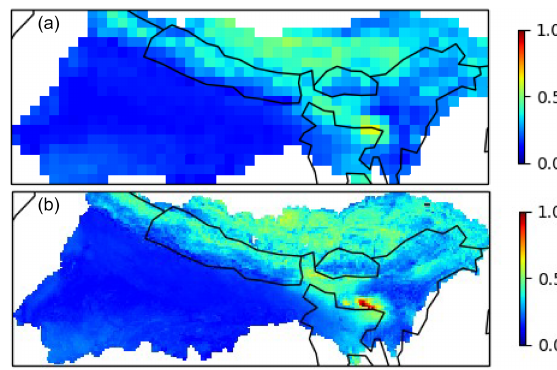
Figure 6. Average of dissimilarity measures between grid cells in the GBM basin and the 10 best-matching donor catchments. A value of 0 indicates a perfect match between the catchment characteristics of the donor and the grid cell. Top is 0.5 ◦ and bottom is 0.1 ◦ hori- zontal